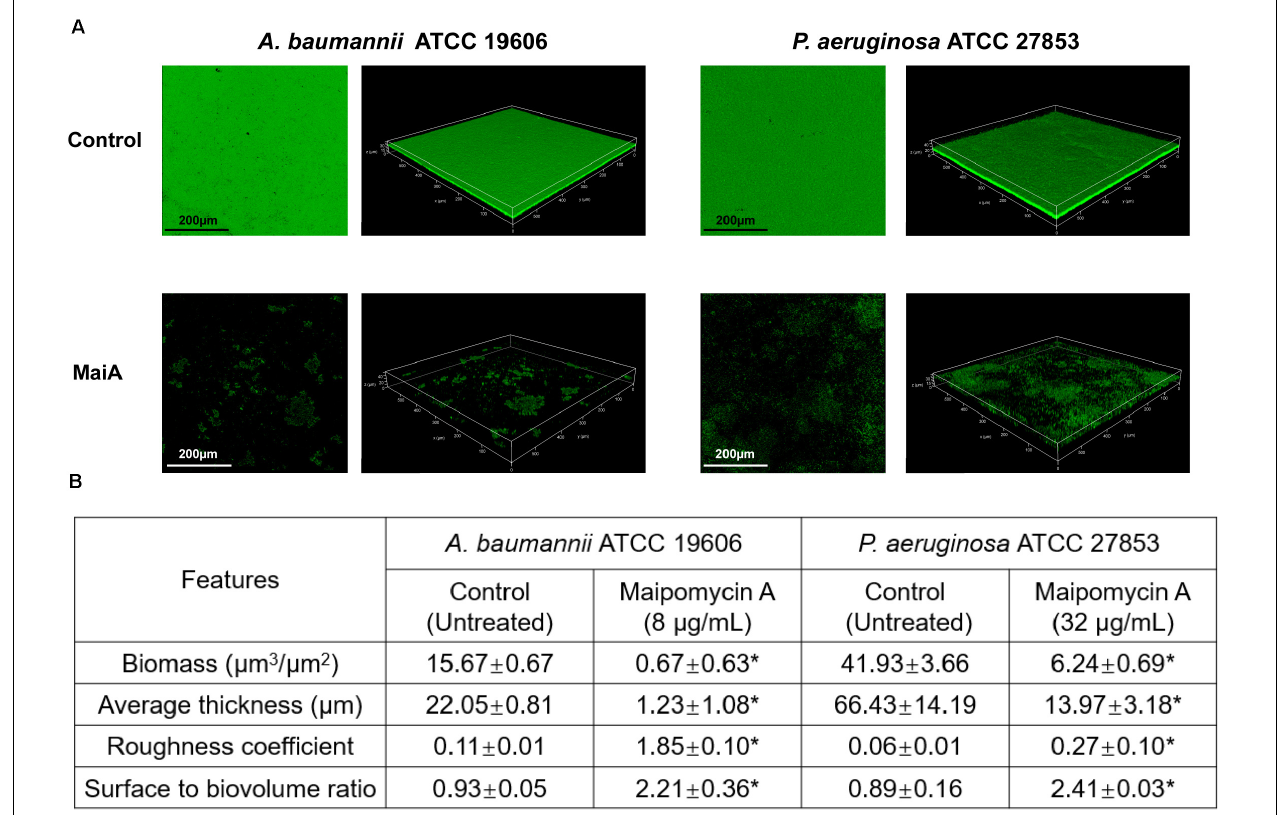
FIGURE 3 | CLSM analyses of biofilm inhibition by maipomycin A (MaiA). (A) 3D image of biofilm after 24 h of incubation in glass coverslips. Control was untreated, and MaiA was treated at MBIC concentrations. (B) Quantitative analyses of biofilm spatial characteristics using COMSTAT software. The values were expressed as mean ± SD. *Indicates P < 0.05 compared with untreated